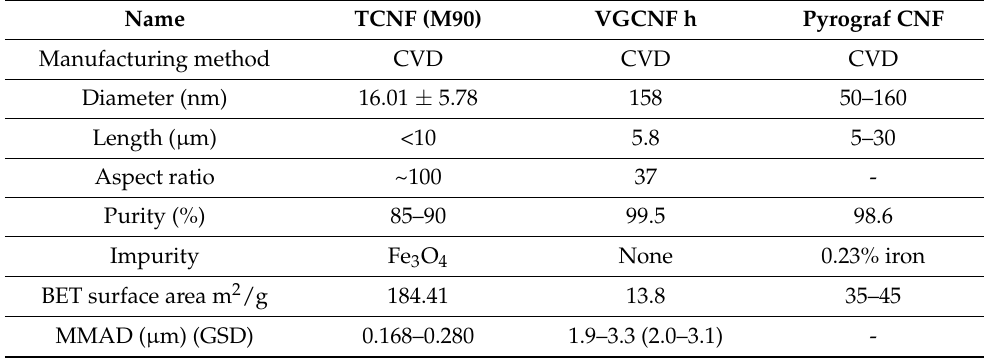
Table 8. Comparison of TCNF, VGCNF h, and Pyrograf